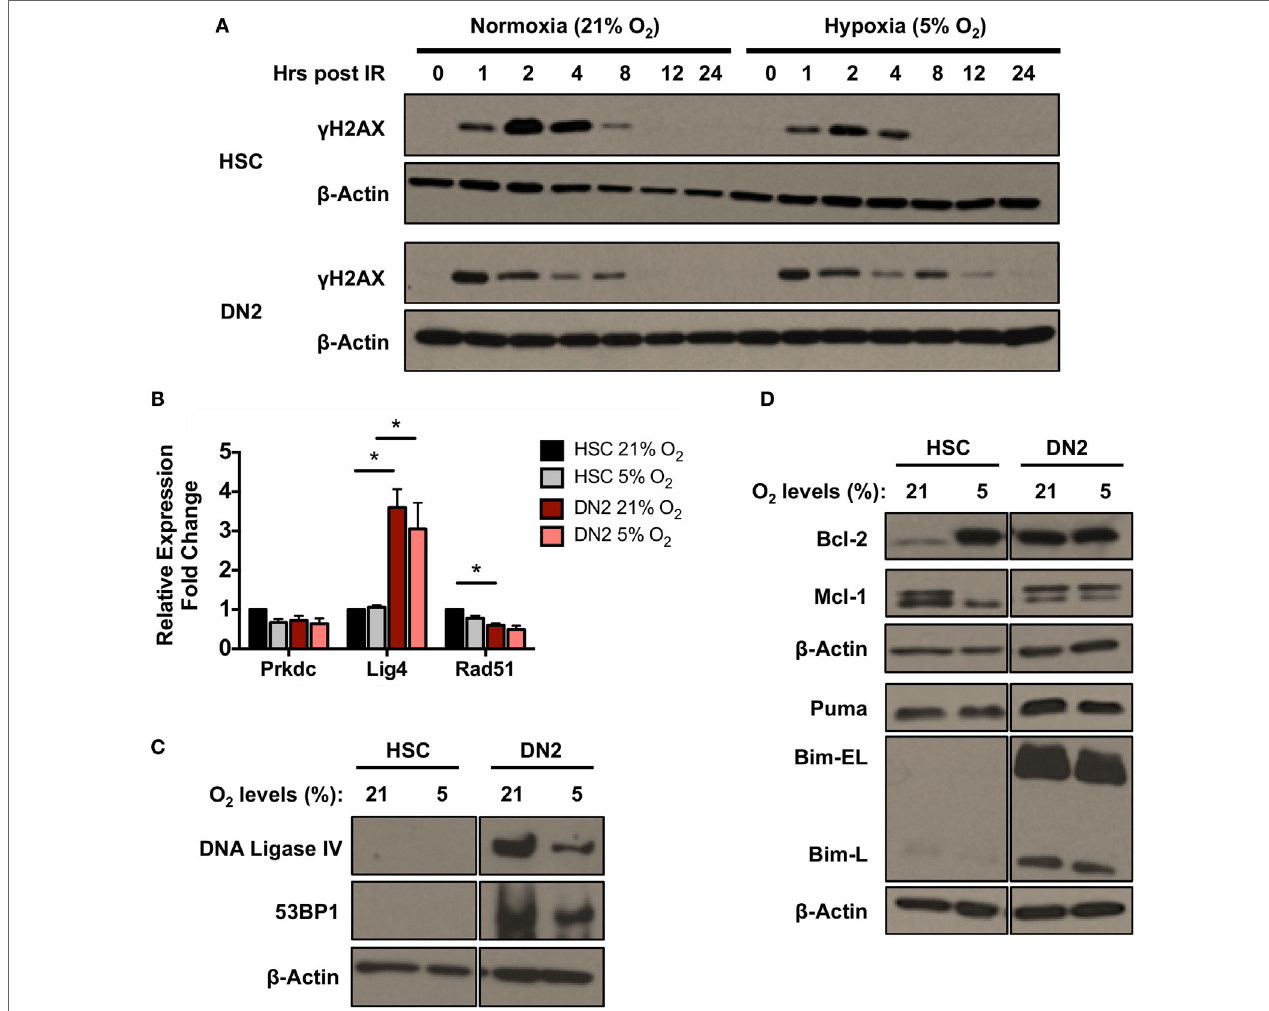
FigUre 5 | DNA repair and apoptotic proteins expression in normoxic and hypoxic NH-hematopoietic stem cell (HSC) and DN2 thymocytes. (a) Western blot analysis of H2AX (Ser139) phosphorylation in DN2 cells and NH-HSCs cultured in either normoxia (21% O 2 ) or hypoxia (5% O 2 ) at 0–24 h post 4 Gy irradiation. (B) mRNA expression levels of DNA repair factors DNA-PKcs (Prkdc), DNA Ligase IV (Lig4) and Rad51 in NH-HSC and DN2 cells in normoxia (21% O 2 ) and hypoxia (5% O 2 ). All values were normalized against β -actin and expressed relative to the NH-HSC normoxic sample. Representative western blots of (c) DNA damage response factors DNA ligase IV and 53BP1; and (D) pro- and anti-apoptotic proteins in NH-HSC and DN2 cells in normoxia (21% O 2 ) and hypoxia (5% O 2 ). All graphs show the average of three biological replicates. (* p < 0.05, multiple t -tests with Holm–Sidak post-test